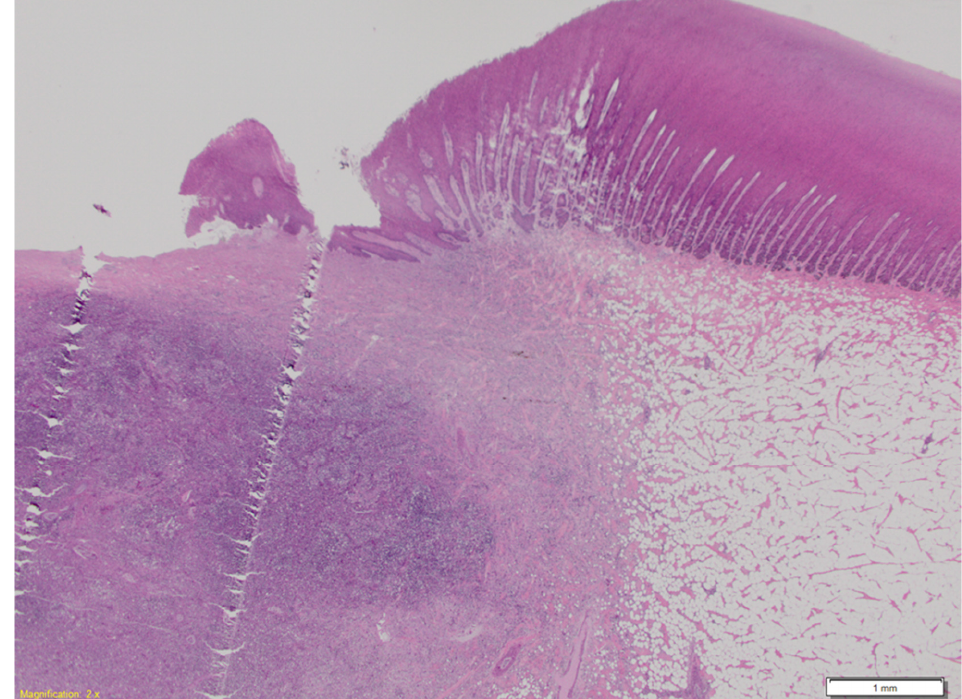
Figure 3. Female juvenile D. delphis , histopathological section of skin lesion from Figure 2A. A core of necrosuppurative inflammation surrounded by fibroplasia replaces the blubber layer, and erupts through the ulcerated epidermis. Hema- toxylin and eosin, 2× magnification.